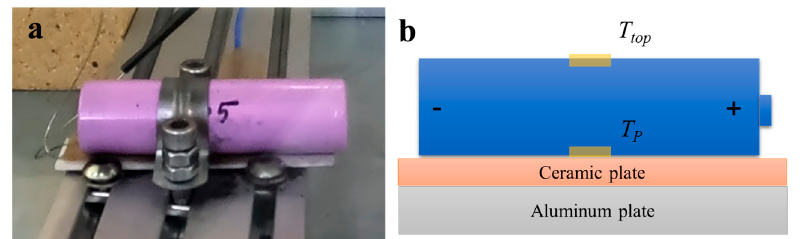
Figure 1. ( a ) Experimental apparatus and ( b ) its diagram for Lithium-ion battery thermal runaway.